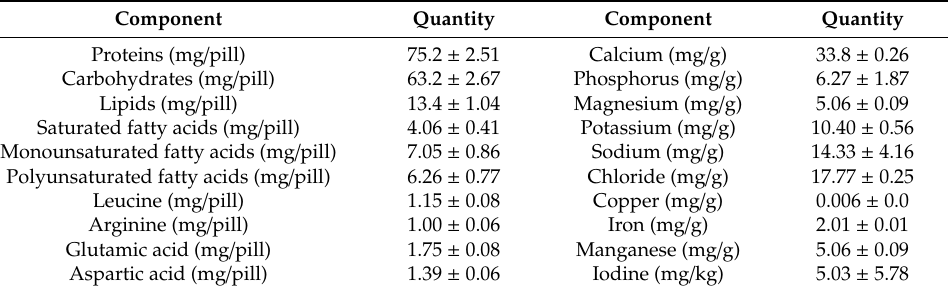
Table 1. Composition of TC from Fitoplacton Marino